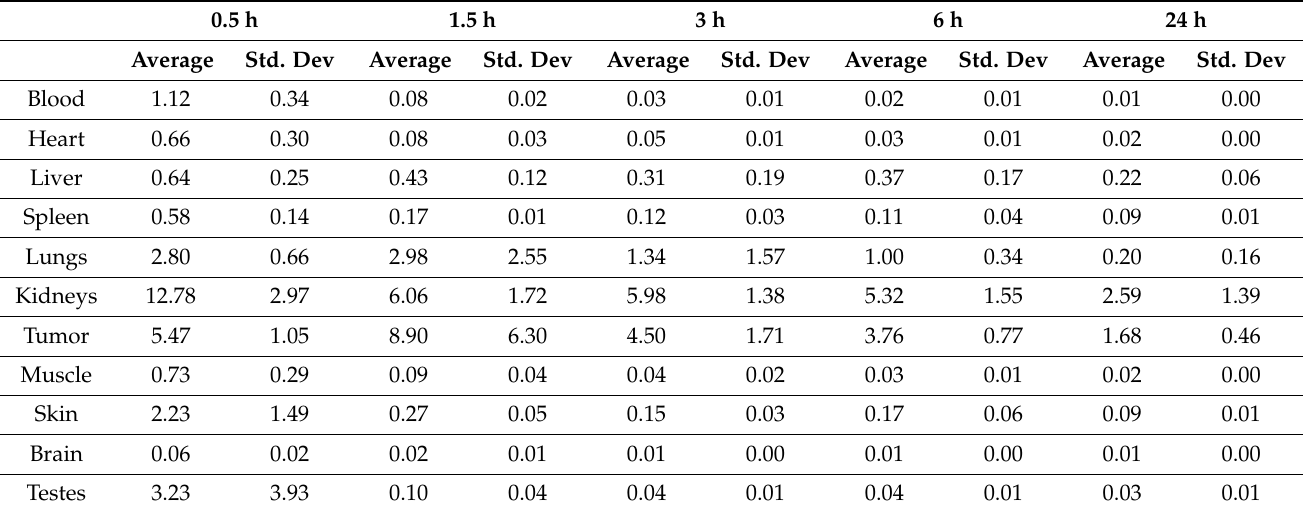
Table 1. Biodistribution of [ 203 Pb]VMT01 in B16-F10 melanoma xenograft